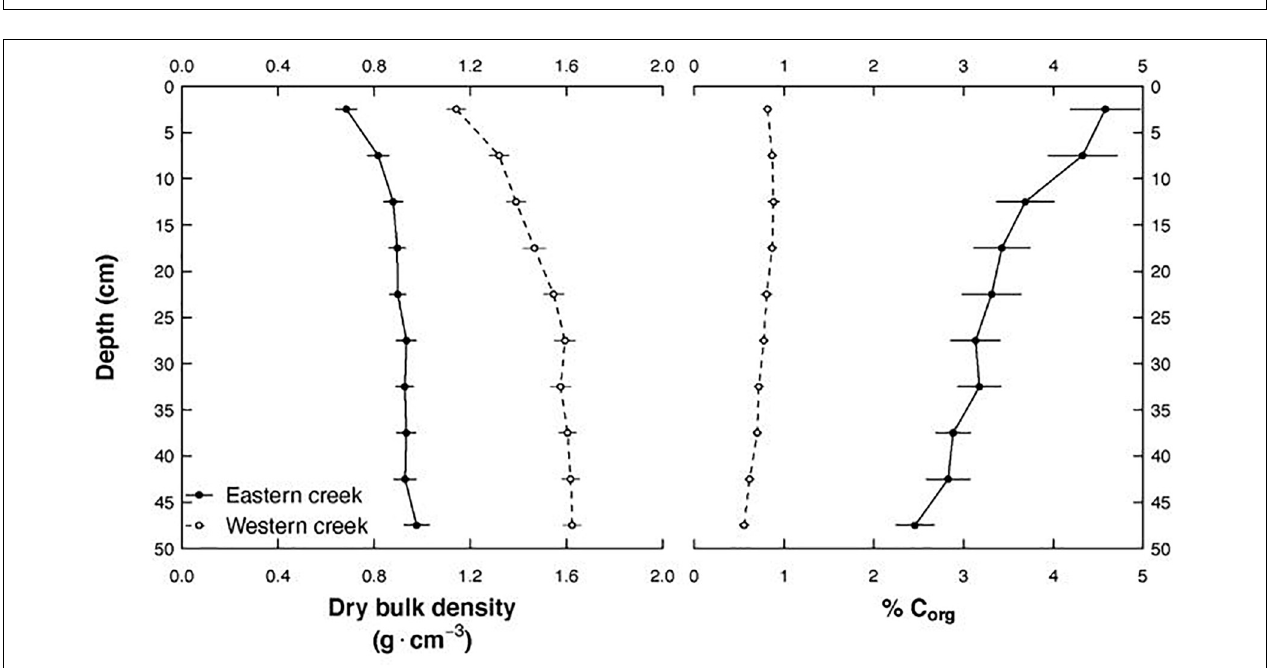
FIGURE 3 | Changes in soil dry bulk density and percentage organic carbon along depth to 50 cm and between the Eastern and Western creeks.